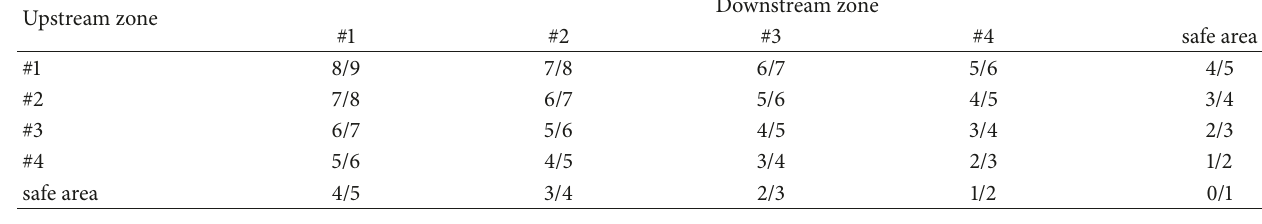
Table 8: Road risk level/weight coefficient according to traditional method.